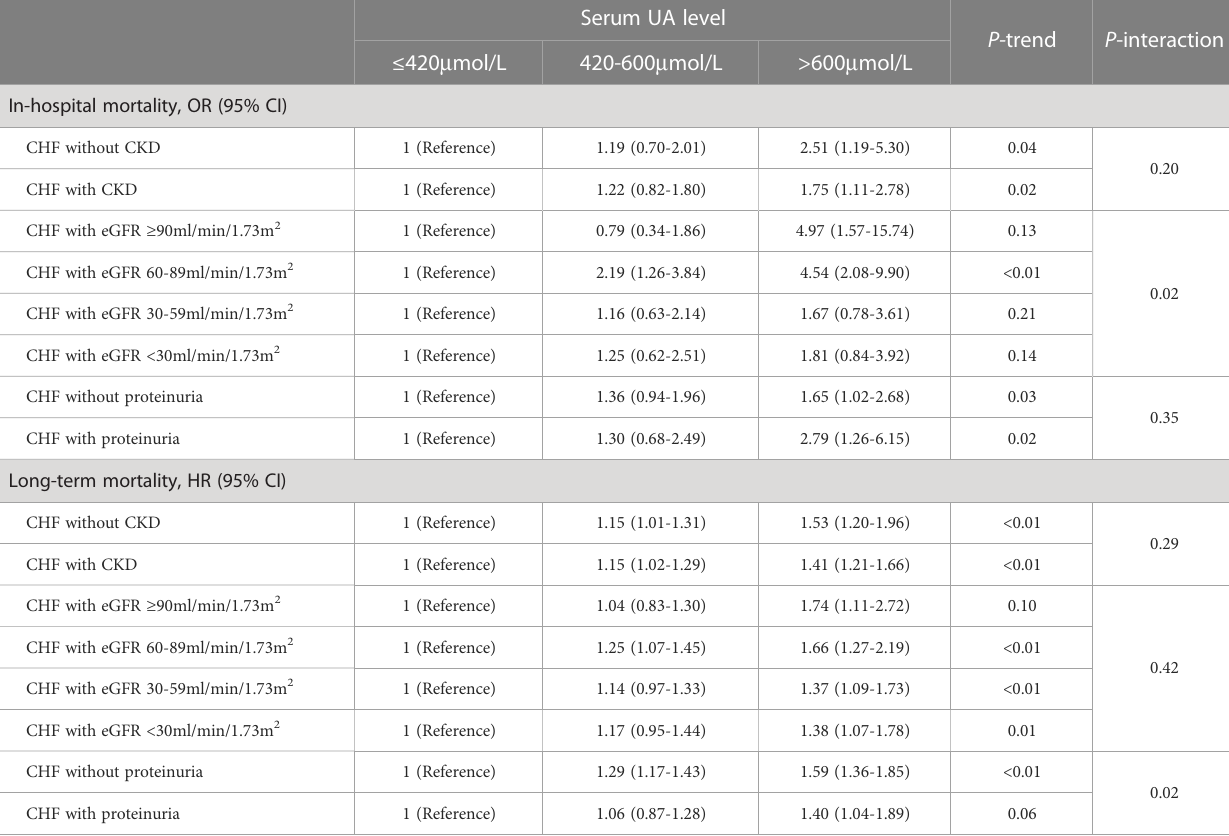
TABLE 3 Mortality risk grouped by serum UA level and strati fi ed by CKD and CKD subtypes.